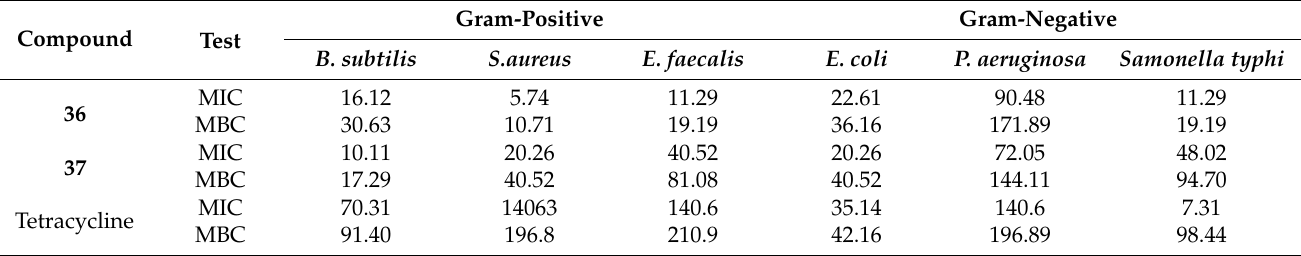
Table 1. In vitro antibacterial activity (minimal inhibitory/bactericidal concentrations, MIC and MBC), expressed in µ M, for sulfonamides 36 and 37 [22]